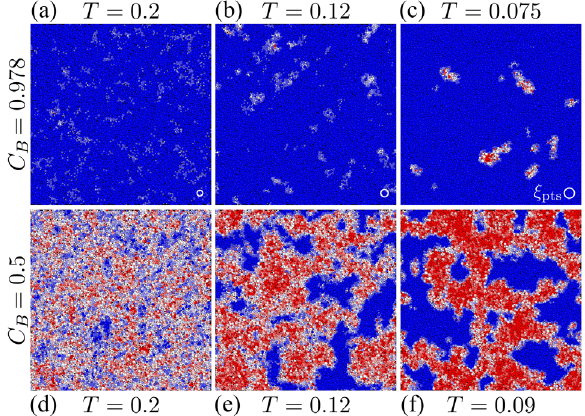
FIG. 6. Temperature evolution of dynamic heterogeneity in 3D. 5. Temperature evolution of dynamic heterogeneity in 2D. t Þ ¼ 0 . 978 , at (a) – (c) Relaxation at early times t ≪ τ α where C B ð Particles are colored following the bond-breaking correlation C i ; different temperatures taken at t ¼ 6 . 5 , 475, and 1 . 8 × 10 7 from B see legend in Fig. 4. (a) – (c) Relaxation at early times t ≪ τ α (a) to (c). (d) – (f) Relaxation close to the α relaxation, where t Þ ¼ 0 . 978 at different temperatures. Snapshots are where C C t Þ ¼ 0 . 5 at different temperatures taken at t ¼ 45 , 2 . 7 × 10 4 , B ð B ð taken at t ¼ 6 ; 2 × 10 3 ; 3 . 2 × 10 8 from (a) to (c). The circles 1 . 2 × 10 7 from (d) to (f). The particles are colored following their indicate the point-to-set length scale ξ discussed in Fig. 21. bond-breaking correlation (see Fig. 4) and drawn with a diameter PTS t Þ ¼ 0 . 5 . (d) – (f) Relaxation close to the α relaxation, where C proportional to either 1 − C i ð t Þ (top) or C i ð t Þ (bottom). The B ð B B Snapshots are taken at t ¼ 500 ; 1 . 5 × 10 5 ; 1 . 7 × 10 8 from (d) to linear size of the box is L ¼ 21 . 5 (f). The linear size of the box is L ¼ 100 .